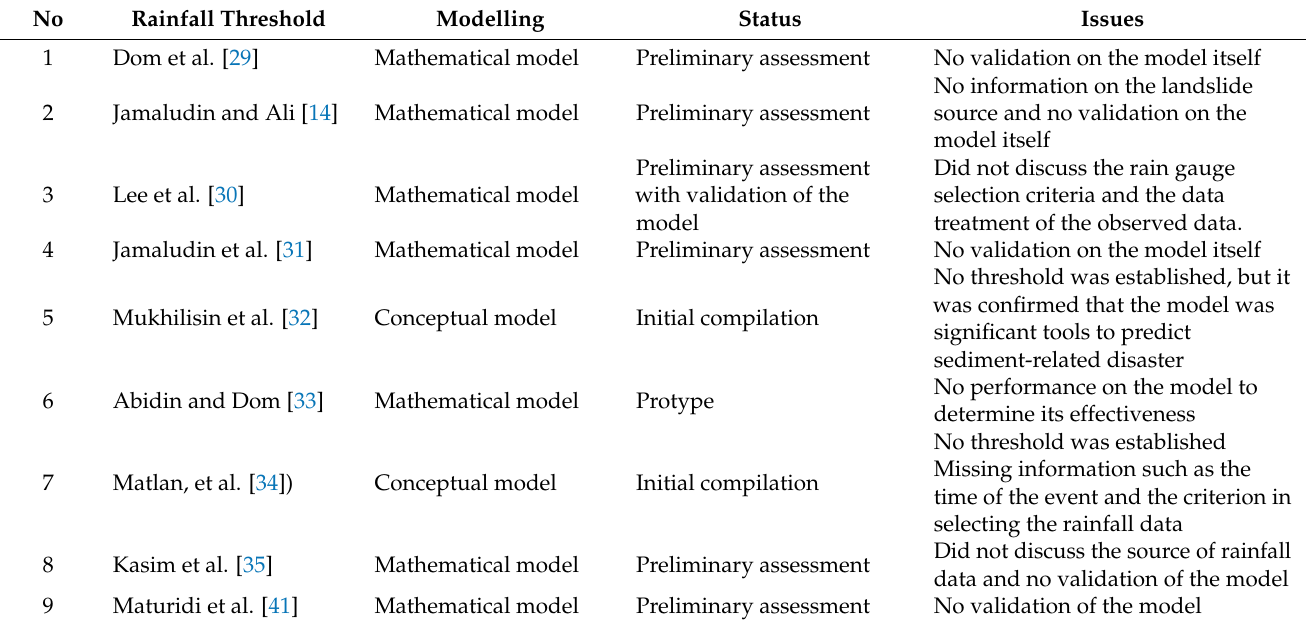
Table 3. Status and issues of the rainfall threshold in